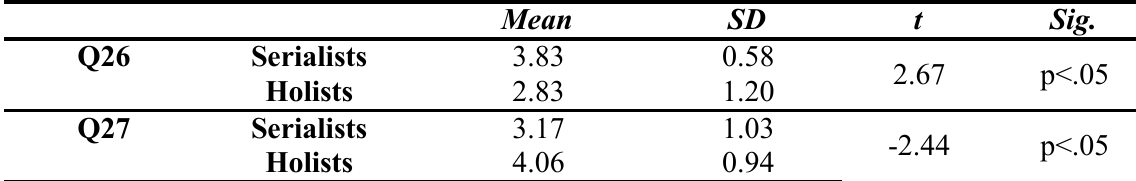
Students’ Responses to Q 26 and